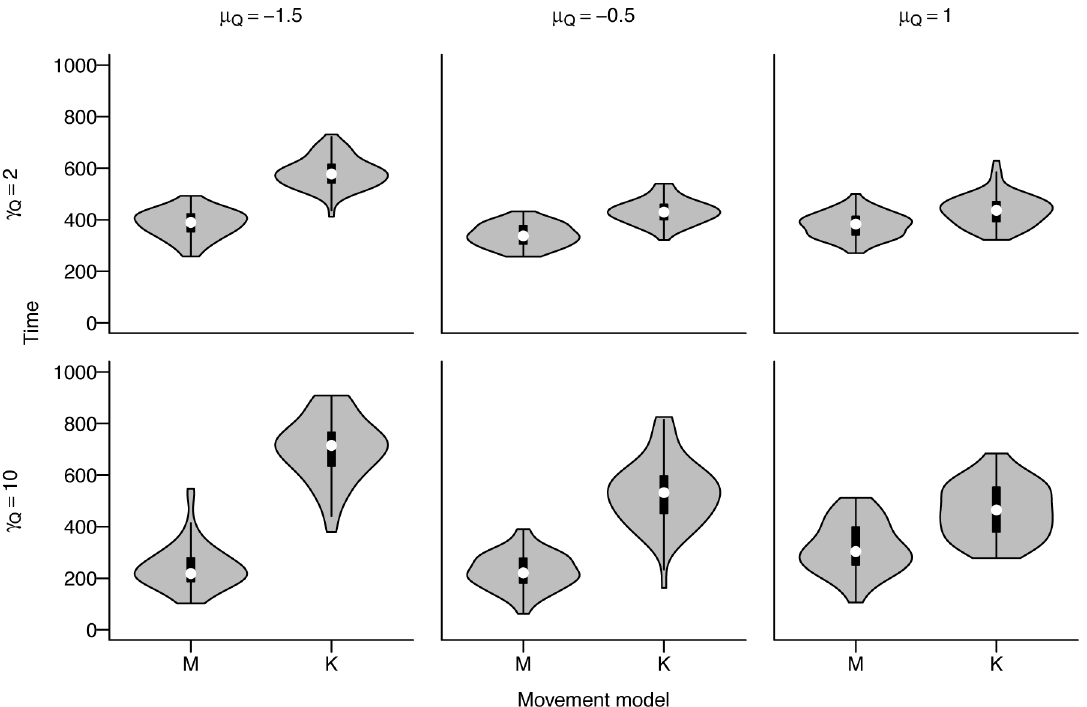
Fig 5. Time spent searching (as opposed to feeding) for memory and kinesis models across different landscape parameter values for patch concentration μ Q and size γ Q for medium regeneration rate β R = 0.01 as a violin plot showing median values and kernel density plot. The memory model is parameterized with best overall parameters, ϕ L = 1 e − 05, ϕ S = 0.01, ψ M = 2, γ Z = 10. In the figure, M = memory, K = kinesis.